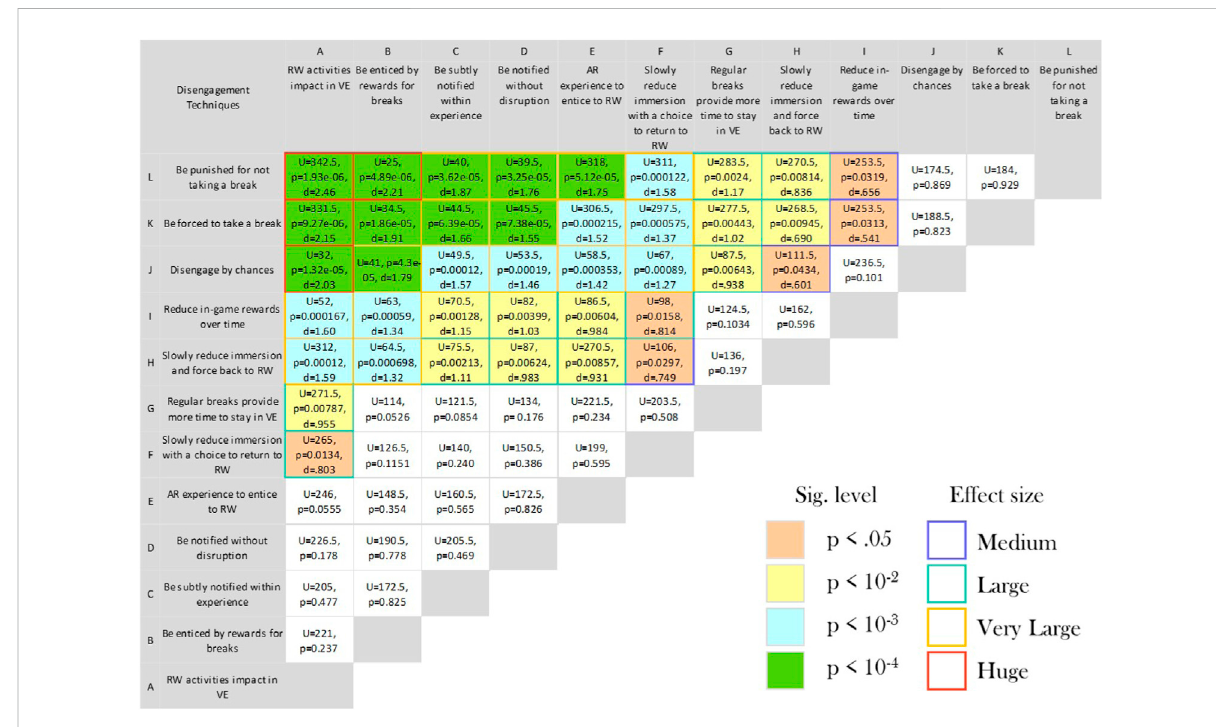
FIGURE 12 The results of post-hoc pairwise comparisons between the twelve general disengagement techniques using Mann-Whitney tests with Bonferroni P-value adjustment. The highlighted pairs indicated a signi fi cant